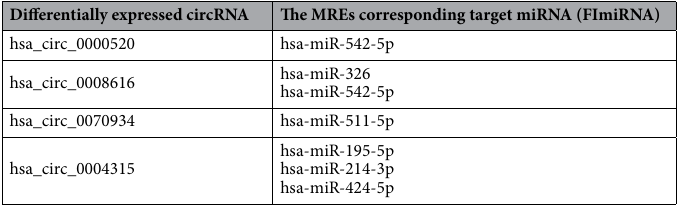
Table 2. circRNA-miRNA interactions.